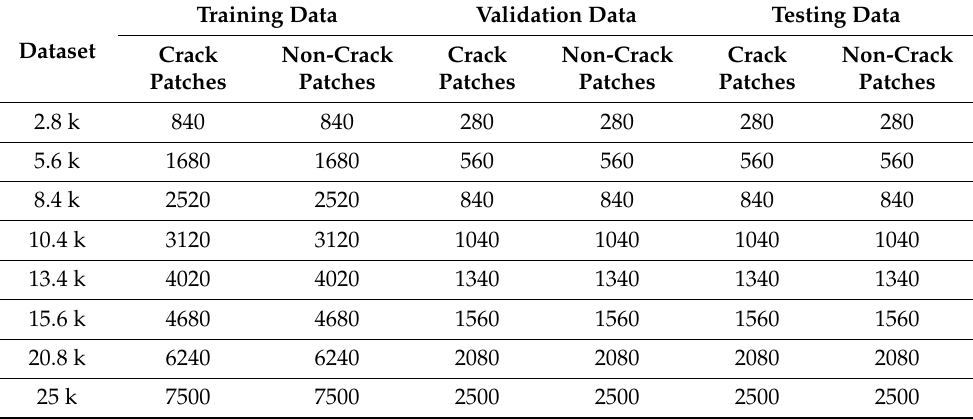
Table 1. Number of training, validation, and testing images in all datasets.